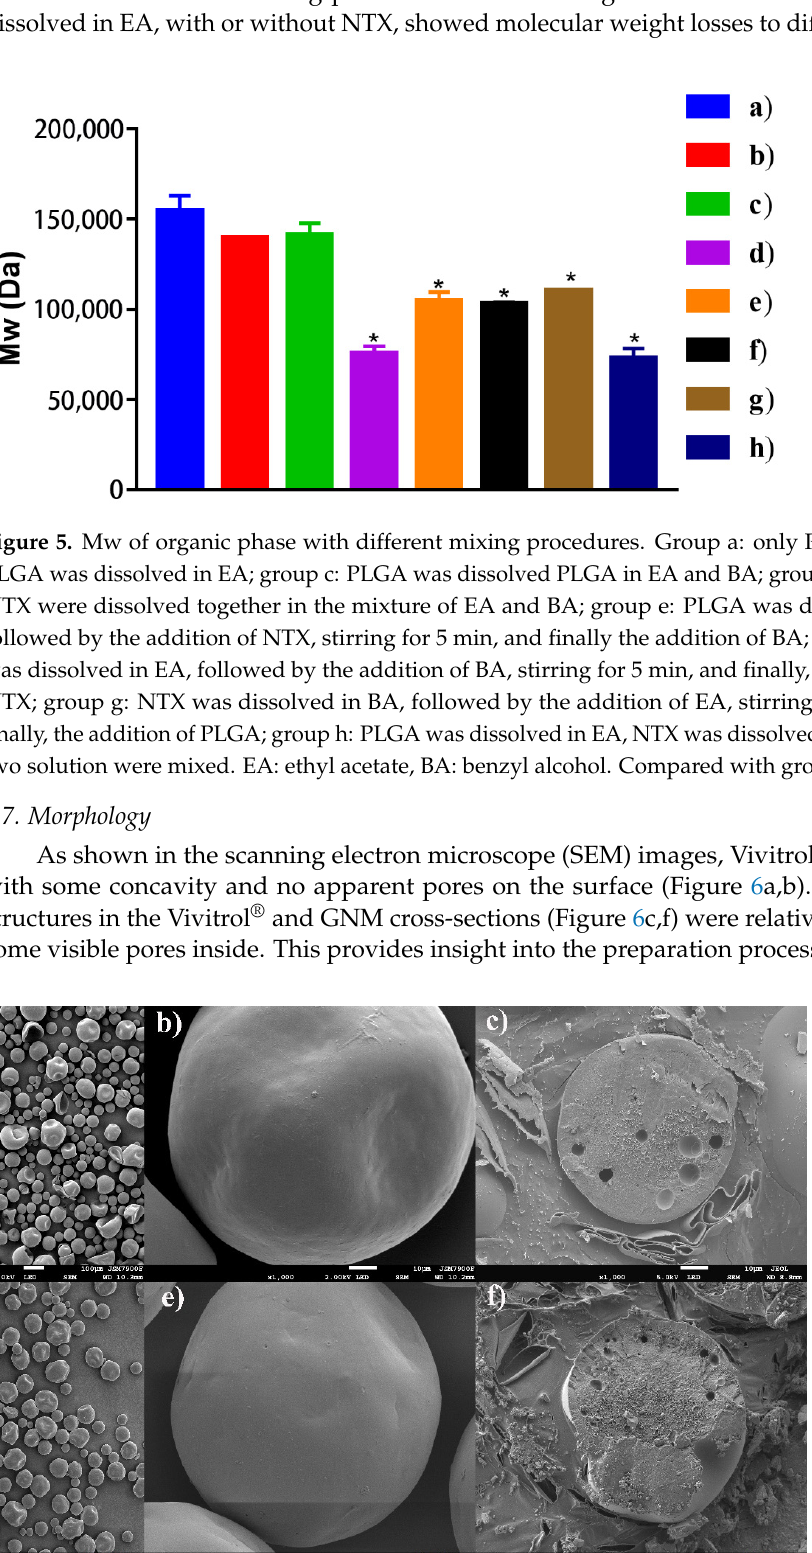
Figure 4. Particle size distribution of Vivitrol ® and the GNM. The laser-diffraction ( a ) and ( b ) and the microscope method ( c ) and ( d ) were both used to detect the particle-size distribution of Vivitrol ® and the GNM.